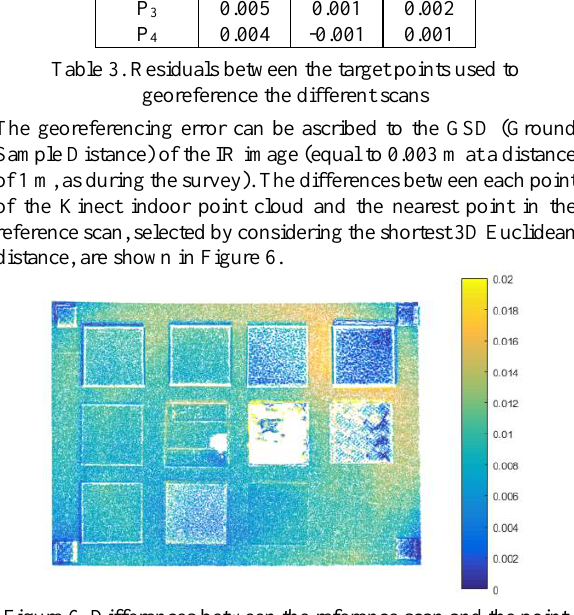
Figure 6. Differences between the reference scan and the point cloud derived from Kinect indoor acquisition